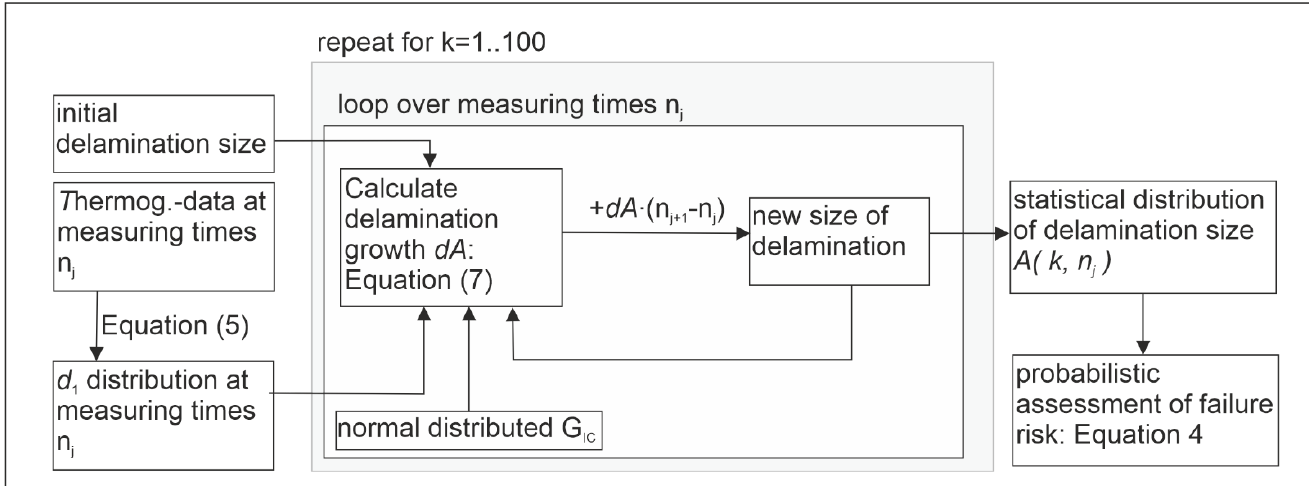
Figure 9. Illustration of the data flow and the calculation routine.